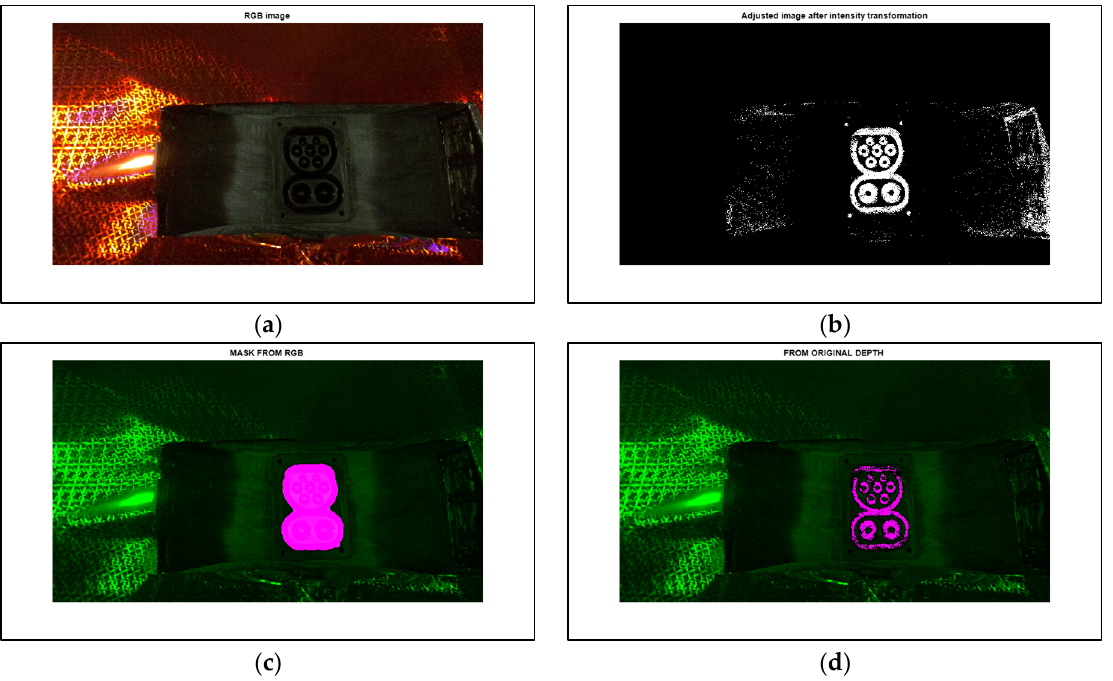
Figure 15. ( a ) Input RGB image, ( b ) result of the intensity transformation, ( c ) obtained binary mask, and ( d ) detected CCS2 connector.